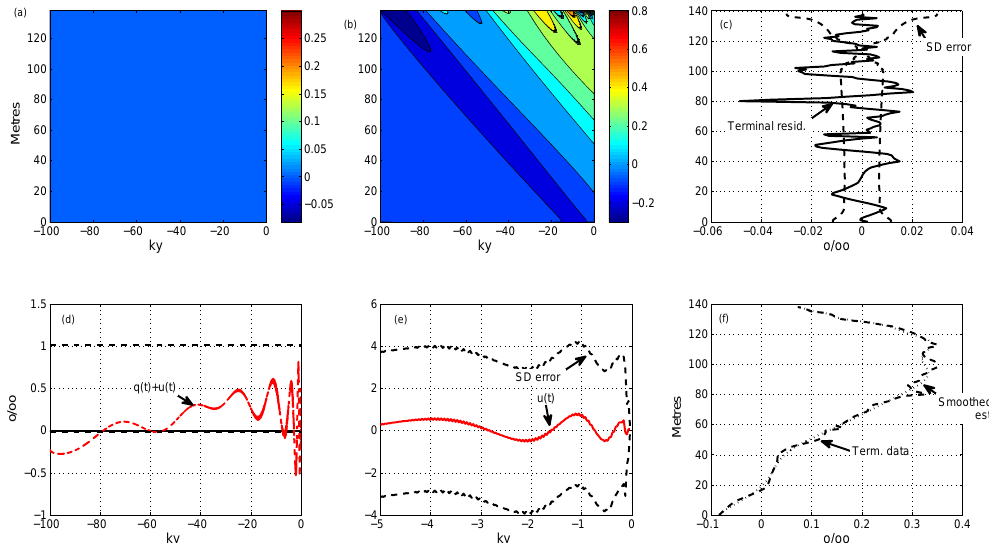
Figure 10. Using the full 140m of the average core, with the zero initial conditions prevented from changing significantly with very small uncertainty and a flat prior, a solution reproducing the δ 18 O w maximum at depth through the arbitrarily reduced values of the terminal data uncertainty, R . All other features are treated as errors. e u ( t ) is now distributed over most of the 100ky, but with no statistical significance anywhere. Strong reduction in the prior uncertainty of the terminal state is visible as the very narrow standard errors in the estimate visible in (c) and in the terminal reproduction of the gross maximum. Large number of outliers in e c (cid:0) z,t f (cid:1) imply an inconsistency between the solution and the prior error estimate.